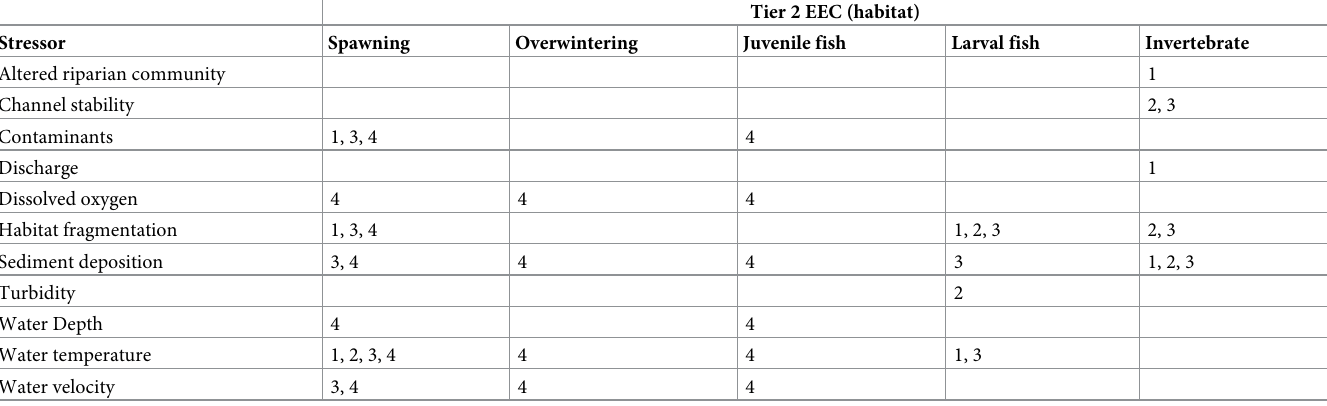
Table 2. Stressors affecting Tier 2 Essential Ecosystem Characteristics (EEC) identified in the application of the conceptual model to case studies in the Canadian River (1), Colorado River (2), Columbia River (3), and Upper Mississippi and Illinois rivers